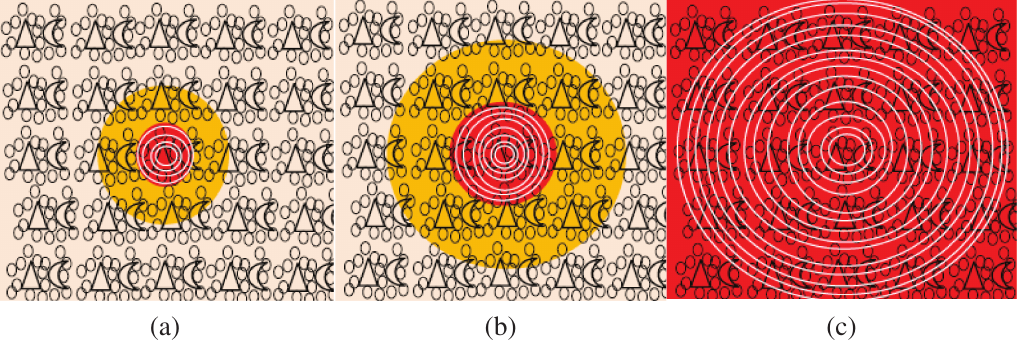
Figure 11: The deduced microwave heating mechanics: (a) hot core induced by microwaves; (b) as heat conducts outside, outward microwave heating is enhanced; (c) a state of homogeneous heating is reached.